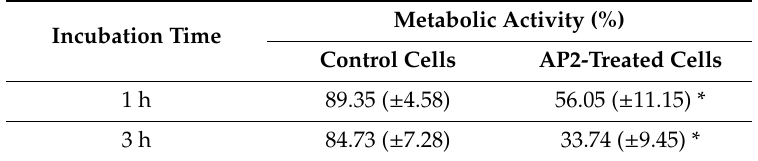
Table 1. Metabolic activity of C. albicans after treatment with G. mellonella AP2.